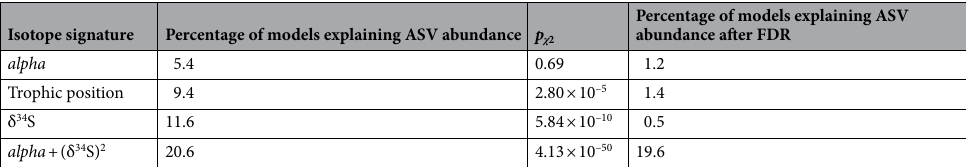
Table 2. Proportion of quasibinomial GLMs explaining the relationship of various isotope signatures with ASV abundance. alpha = proportional use of littoral carbon.